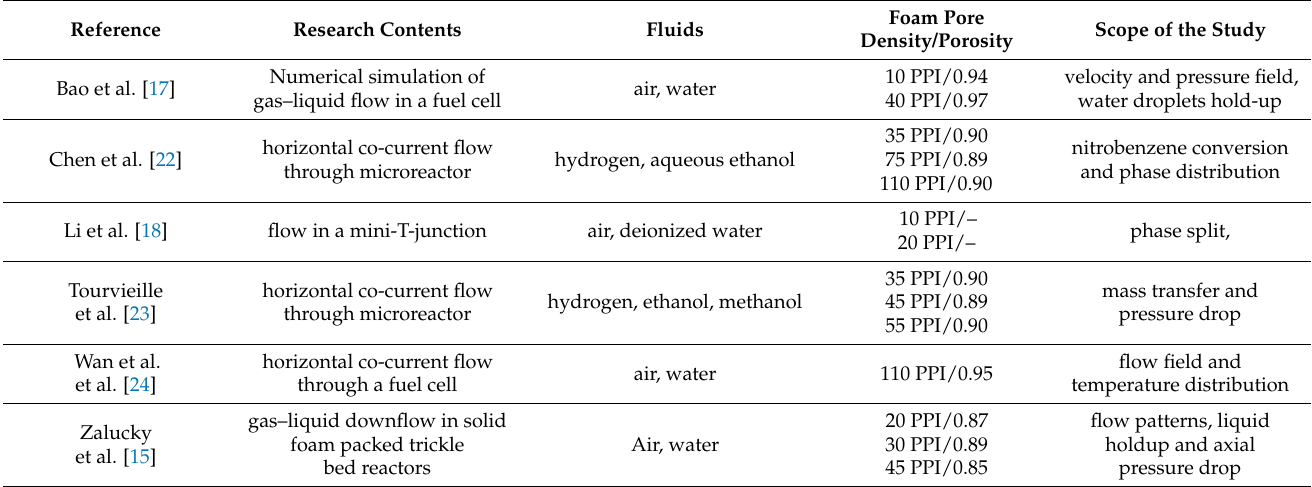
Table 1. Overview of studies on gas and liquid flow through channels filled with metal foams. Papers not dealing with boiling or